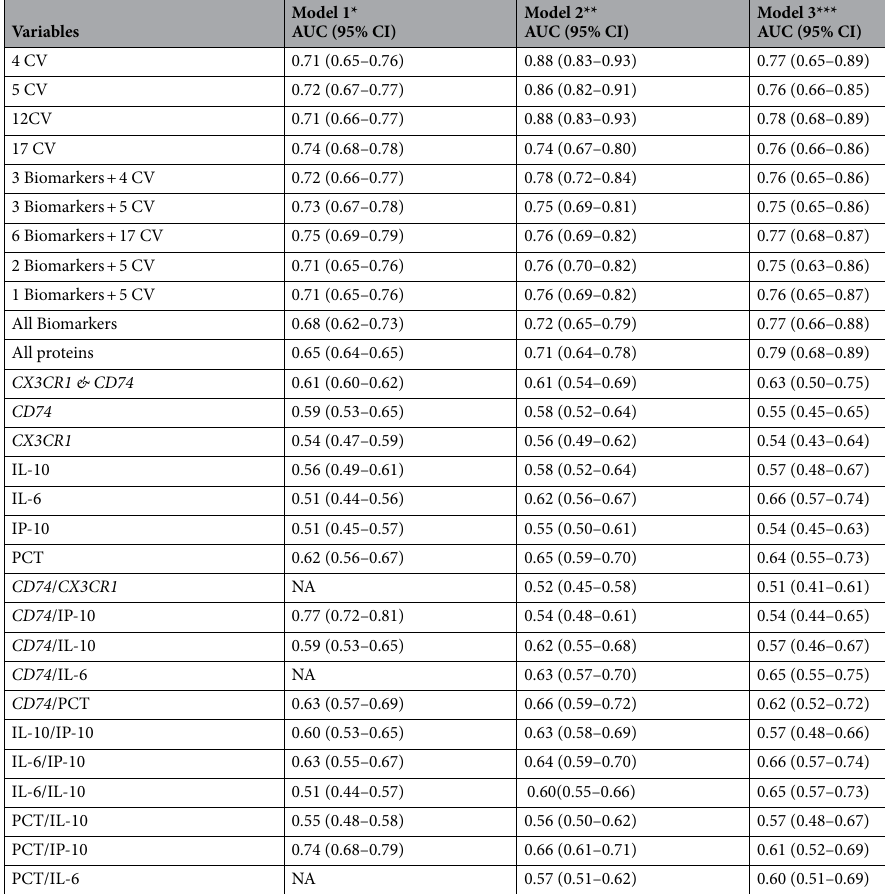
Table 4. Area under the receiver operating curve of biomarkers and clinical variables combinations for the diagnosis of sepsis. * MODEL 1: Hospital arm sepsis (n = 163) vs hospital arm no sepsis (n = 257). ** MODEL 2: Hospital arm sepsis (n = 163) vs no sepsis (suburban arm n = 47 & hospital arm n = 245). *** MODEL 3: Hospital arm sepsis with positive blood culture (n = 55) vs no sepsis (suburban arm n = 47 & hospital arm non sepsis n = 245). CD74 , HLA class II histocompatibility antigen gamma chain; CX3CR1; CX3C chemokine receptor 1; IL , Interleukin; PCT, procalcitonin. Clinical variables (CV) combination legend: 4 CV: